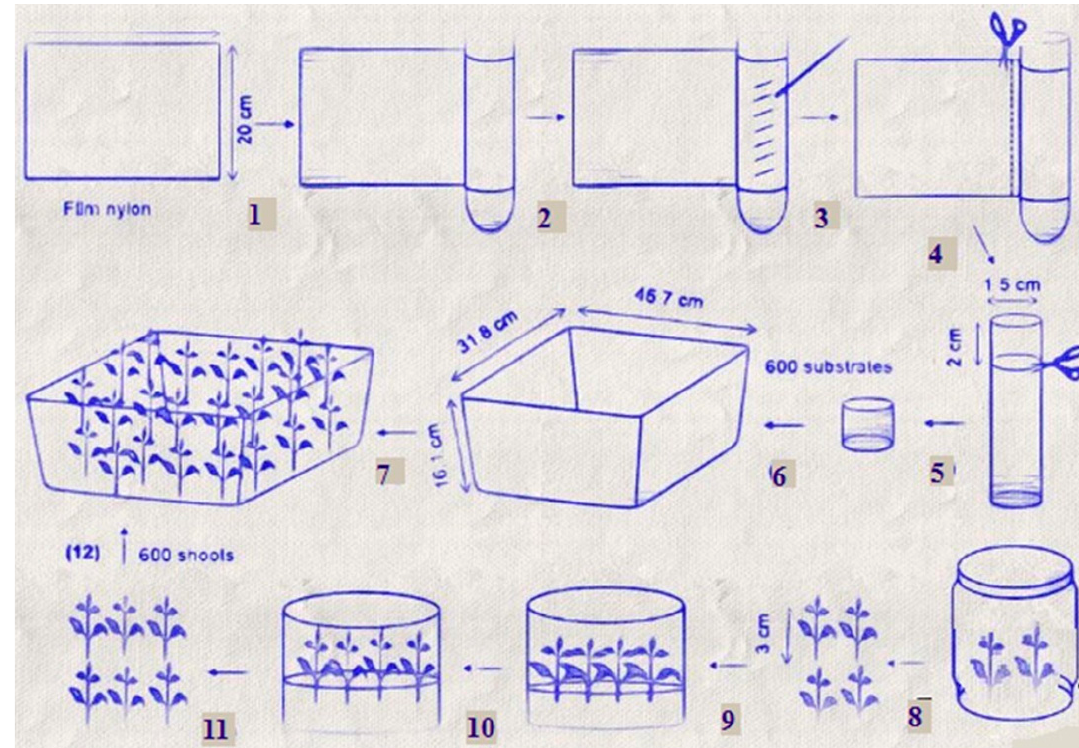
Figure 2. Microponic system diagram adapted from Tung et al., 2018 [20].